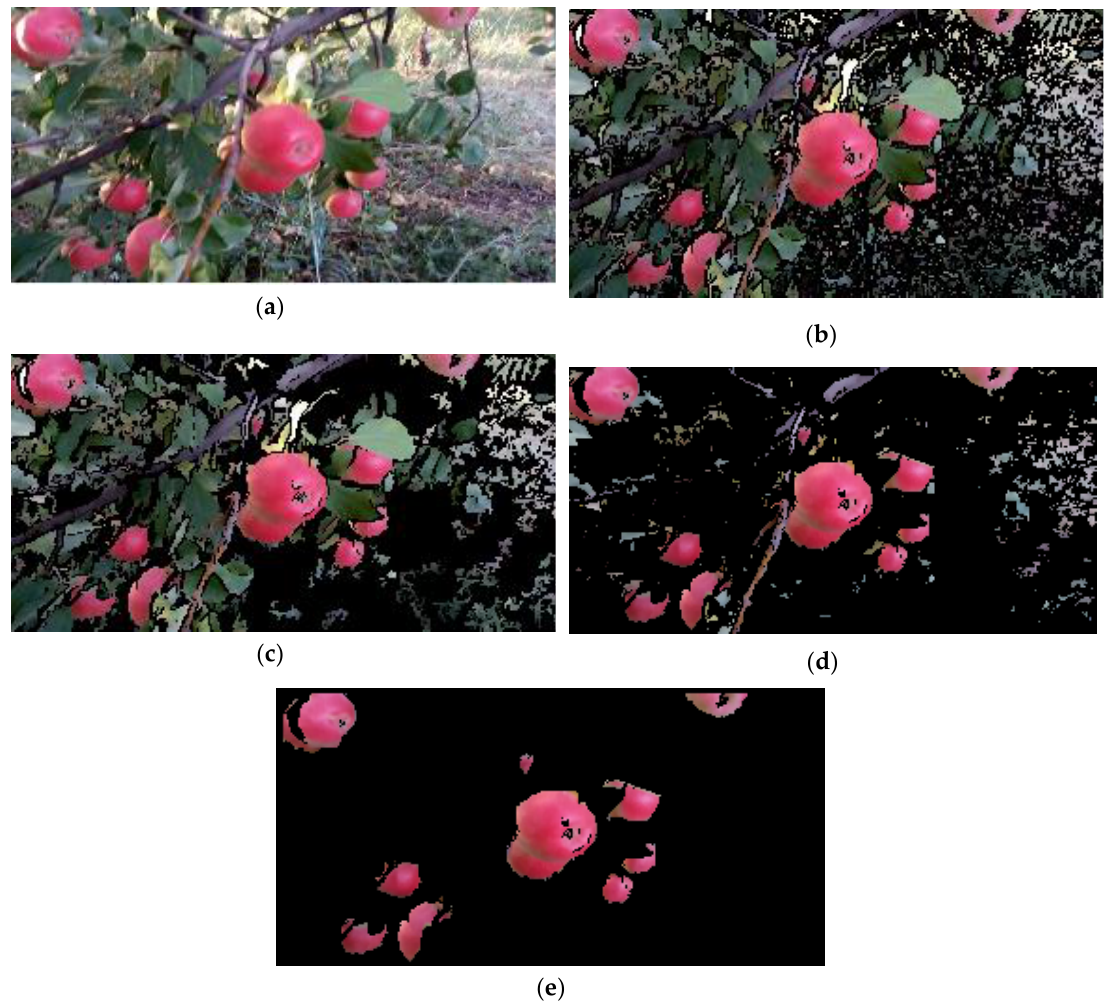
Figure 3. Example of the steps in apple segmentation. ( a ) Original video frame. ( b ) First step of segmentation based on color thresholding in the L*u*v* color space. ( c ) Second step, based on texture features. ( d ) Third step, based on intensity transformation. ( e ) Final step, based on thresholding in RGB color